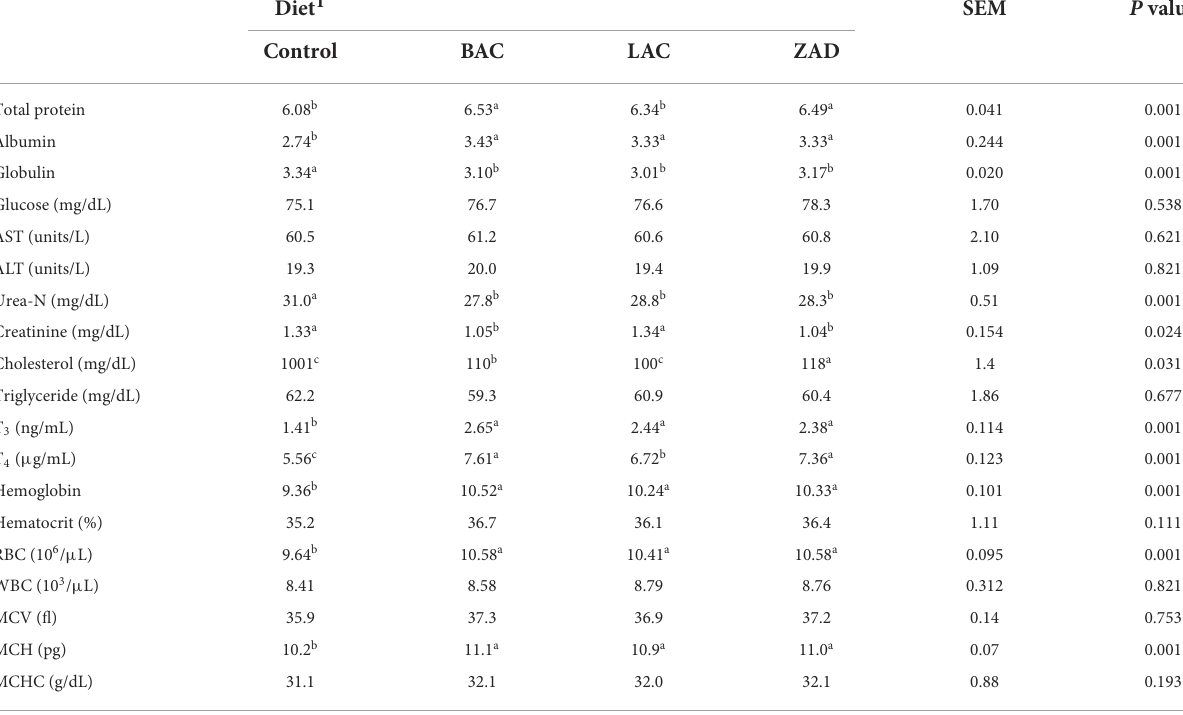
TABLE 3 Blood metabolites (g/dL) and hematological parameters of growing Farafra lambs fed diets containing date palm leaves treated with different probiotics. Diet 1 SEM P